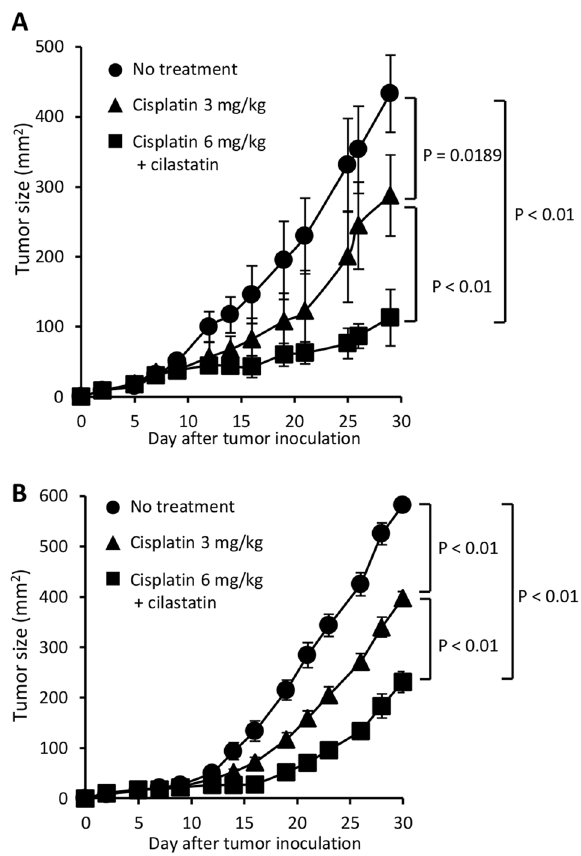
Figure 4. Antitumor effects of cisplatin combined with cilastatin. BALB/cA mice were inoculated s.c. with CT26 tumor cells ( A ), and SCID mice were injected s.c. with A549 tumor cells ( B ). The mice were treated with 3 mg/kg or 6 mg/kg cisplatin i.p. on days 6, 9 and 12 with or without administration of cilastatin s.c. from days 6 to